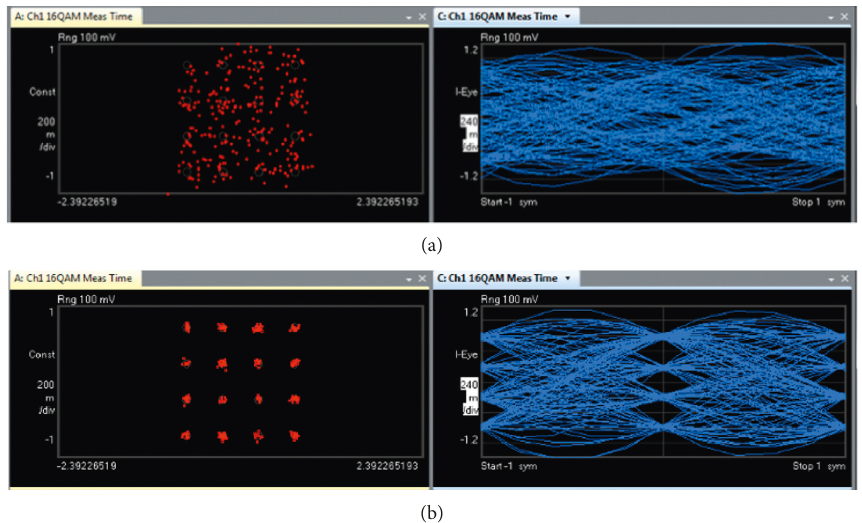
Figure 13: Experimental performance investigation at 24.7 GHz with 800Mbit/s throughput. (a) Scenario 1 and (b) Scenario 4. Table 1: Experimental characterization of the proposed filtenna for four configurations.